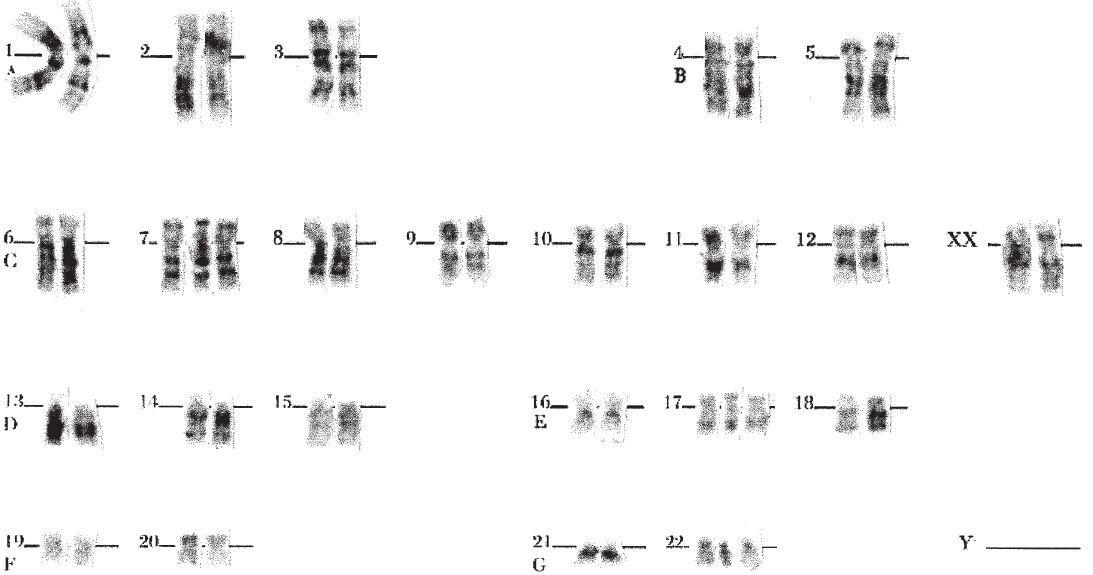
Fig. 3. A case of simple adenoma (SA) with thyroiditis, showing a hyperdiploid karyotype of 49, XX, + 7, + 17, + 22 in 25% of studied cells. Table 2 Results on the in situ hybridization compared with flow cytometry Case no. 9 Case no. 39 Case no. 43 Case no.